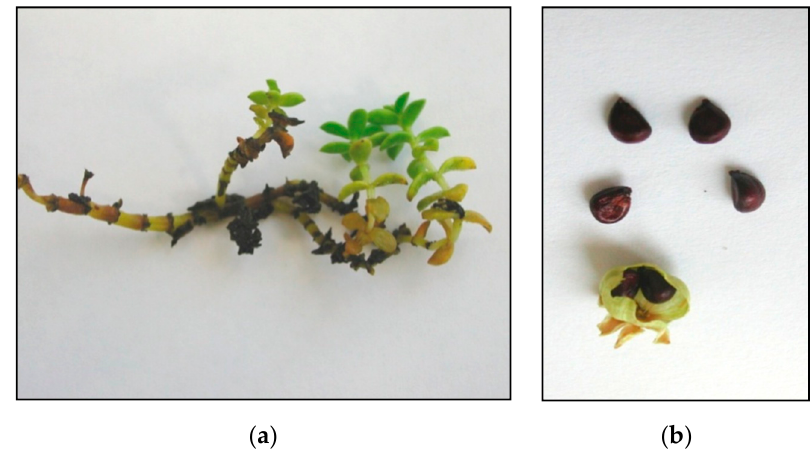
Figure 8. Starting material for tests: shoots ( a ) and seeds ( b ).